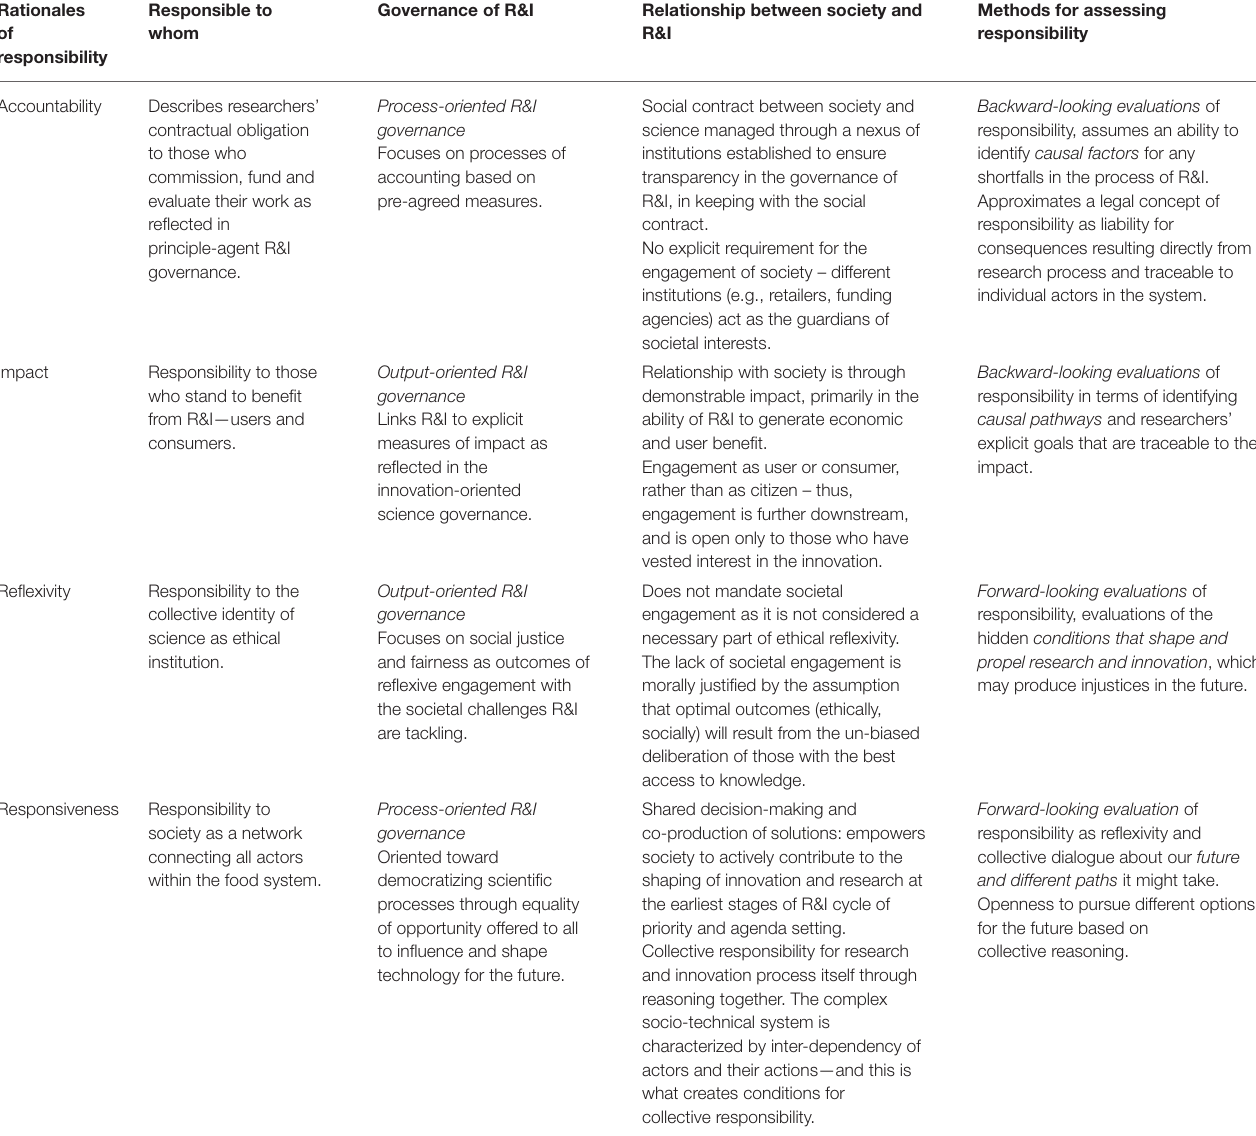
TABLE 2 | Rationales of responsibility in the context of food